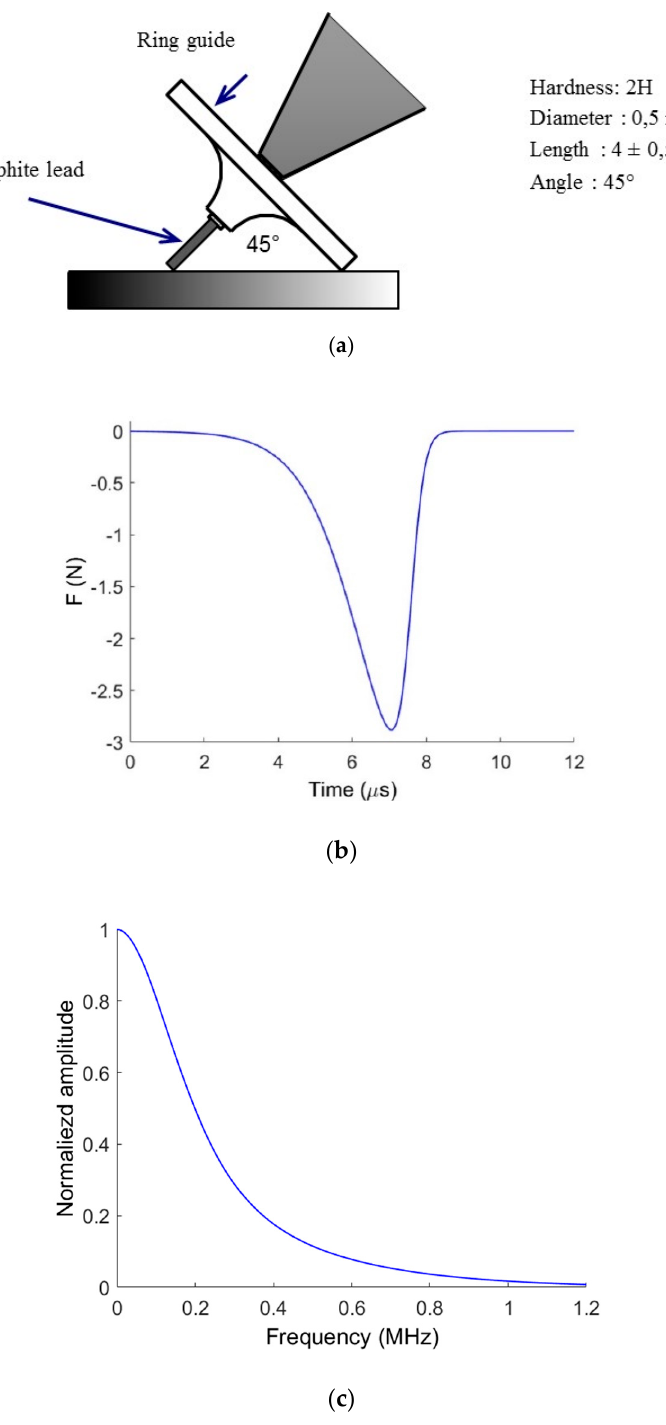
Figure 2. ( a ) Main characteristics of the pencil lead-break procedure (PLB); ( b ) temporal evolution of the applied force exerted by a 2H lead break of 0.5 mm diameter, 4 mm length and with 45° inclination with respect to the surface; and ( c ) amplitude in the frequency domain.